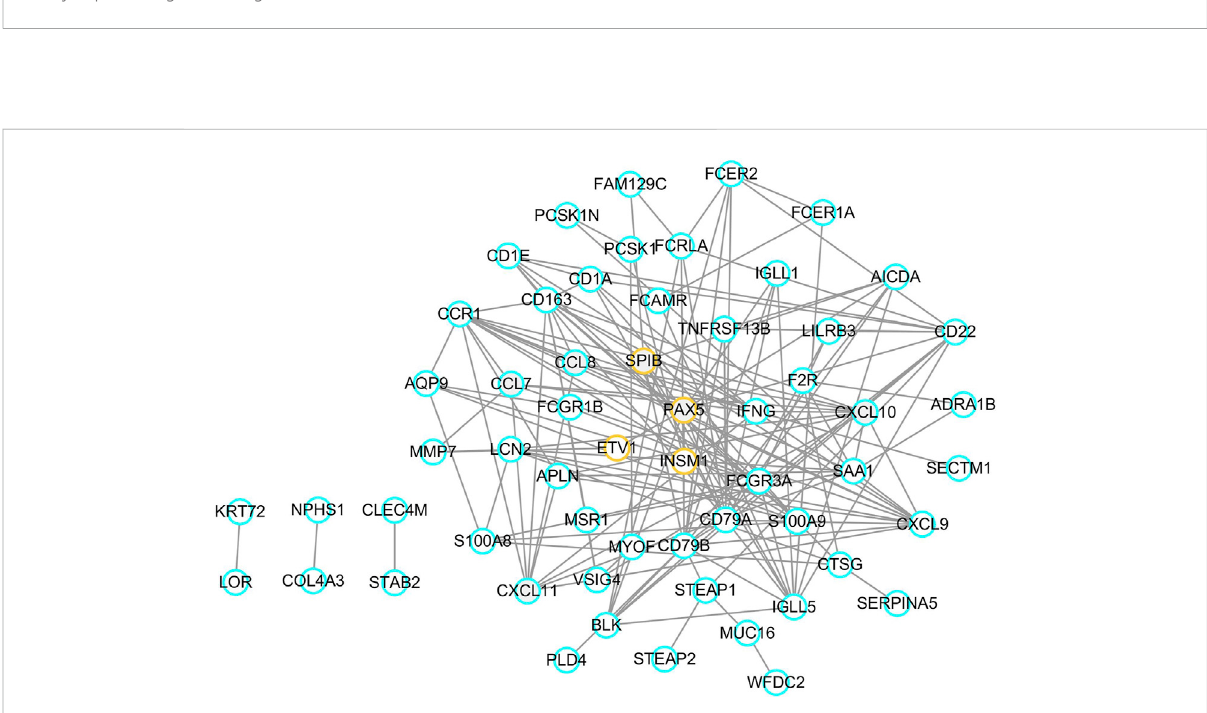
FIGURE 5 Transcription factor regulatory network. Orange circles represent transcription factors and blue circles mean common